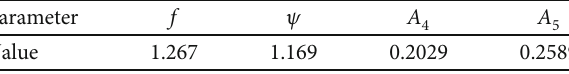
Table 5: Results of overall